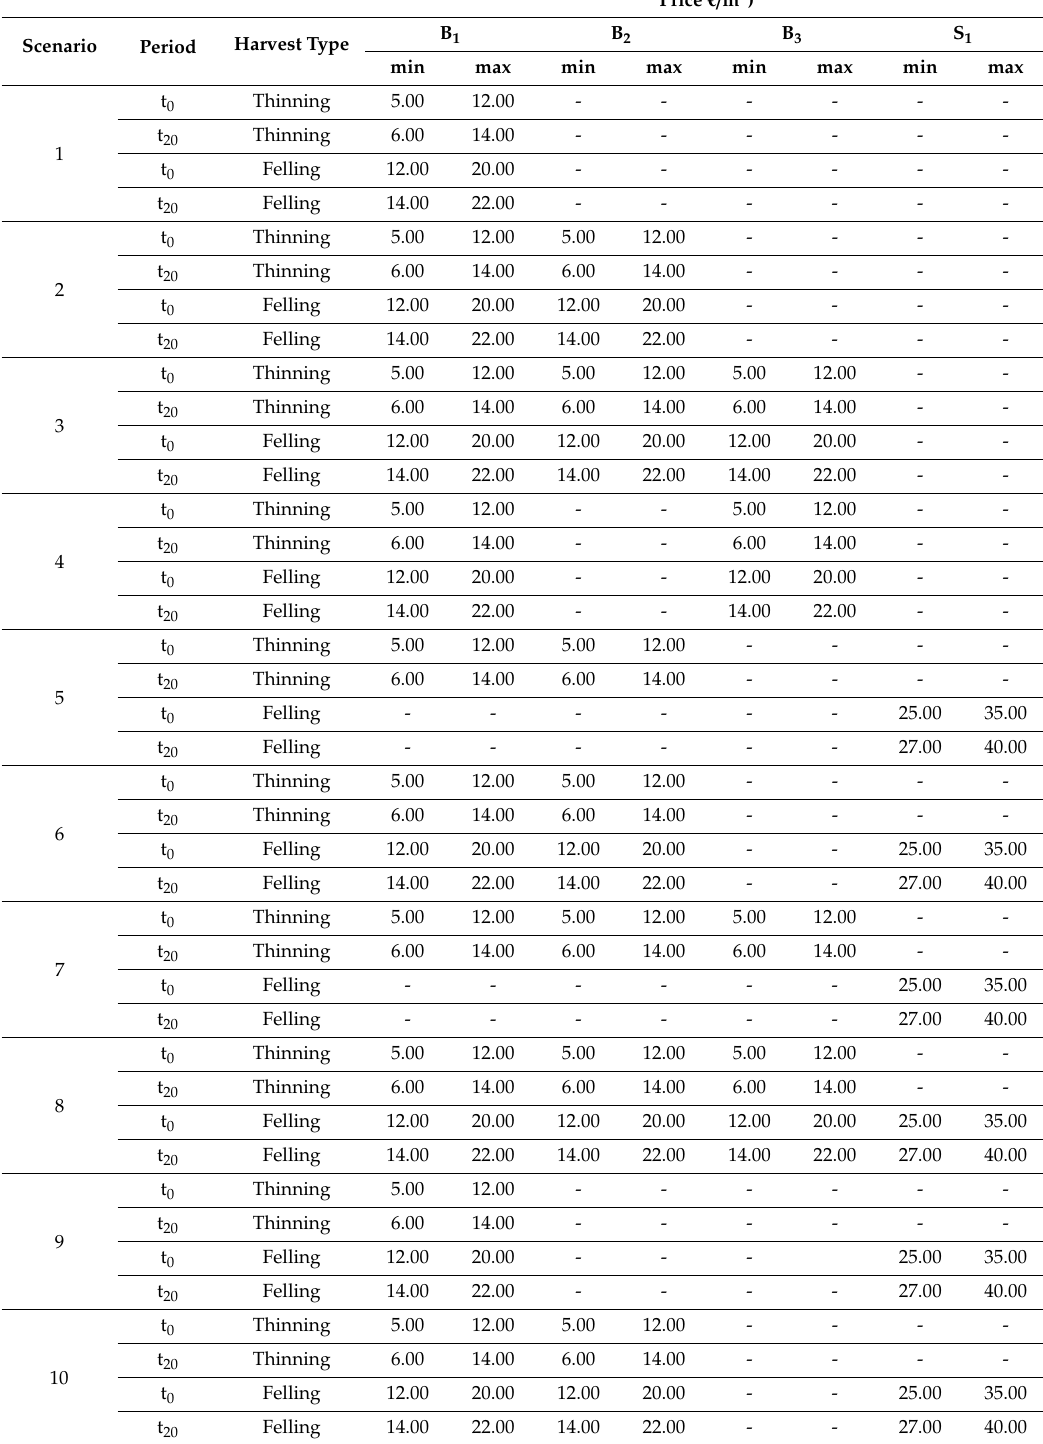
Table A3. Price intervals (range please define all abbreviated terms upon their first appearance in a figure or table (min, max)) for each industry, scenario and type of